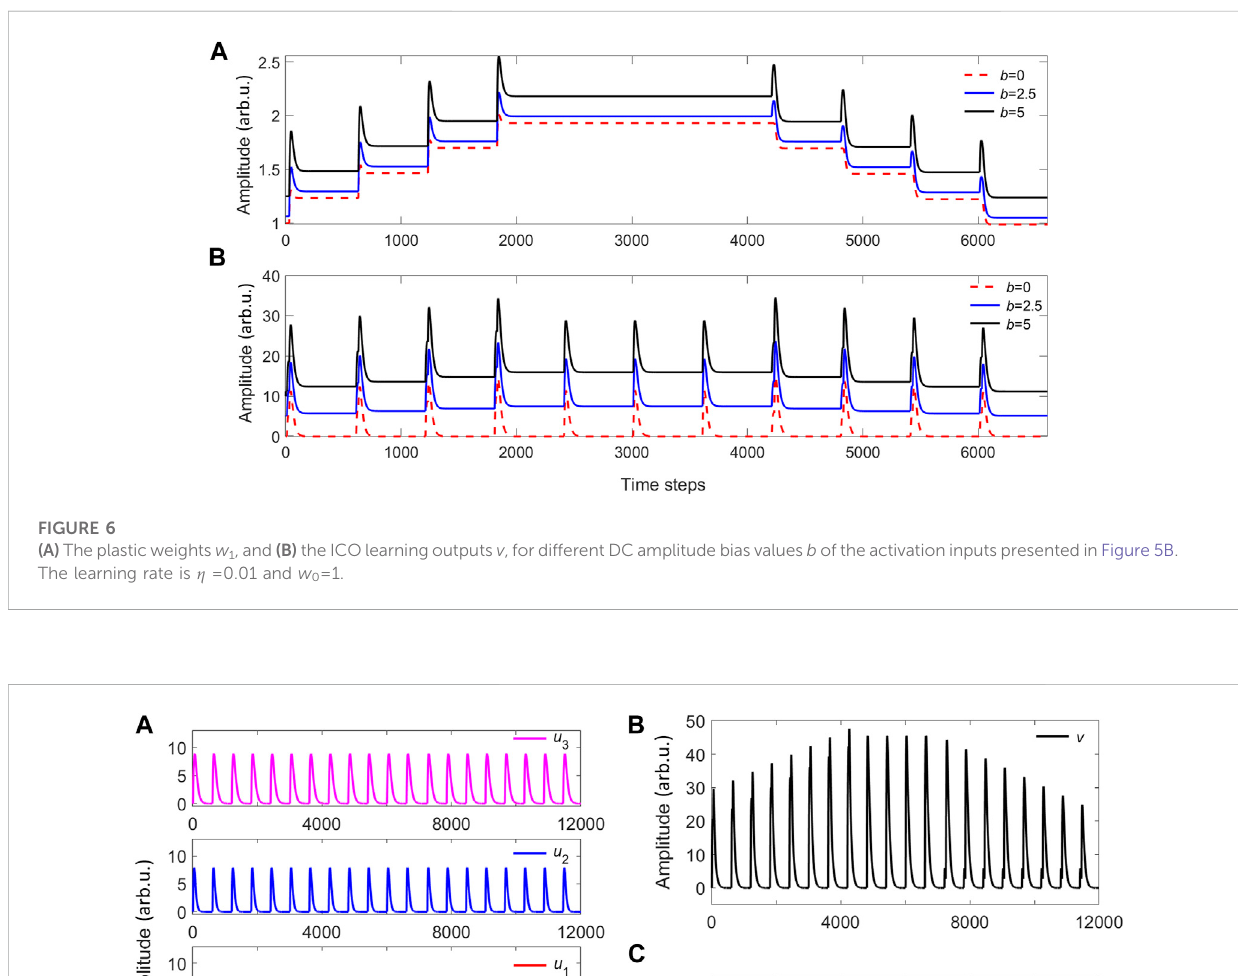
input time frames, x 0 is delayed by T = 45 time steps with respect to x 1 ; in the next four time frames the reference signal x 0 is zero; in the last eight frames, x 0 is 45 time steps ahead of x 1 ( T = − 45). The fi ltered raw inputs result in the activation input sequences u Figure 7A. These fi ltered inputs are applied to the ICO learning rule with a learning rate of η = 0.01 and a weight for the reference signal equal to w 0 = 1. The ICO learning output v signal is shown in Figure 7B, while the update of the adaptive weights w i ( i > 0) is shown in Figure 7C. The differences among the plastic weights w i are given by the different input activation amplitudes u i and the time overlap between the stimuli fi ltered signals and the reference one.